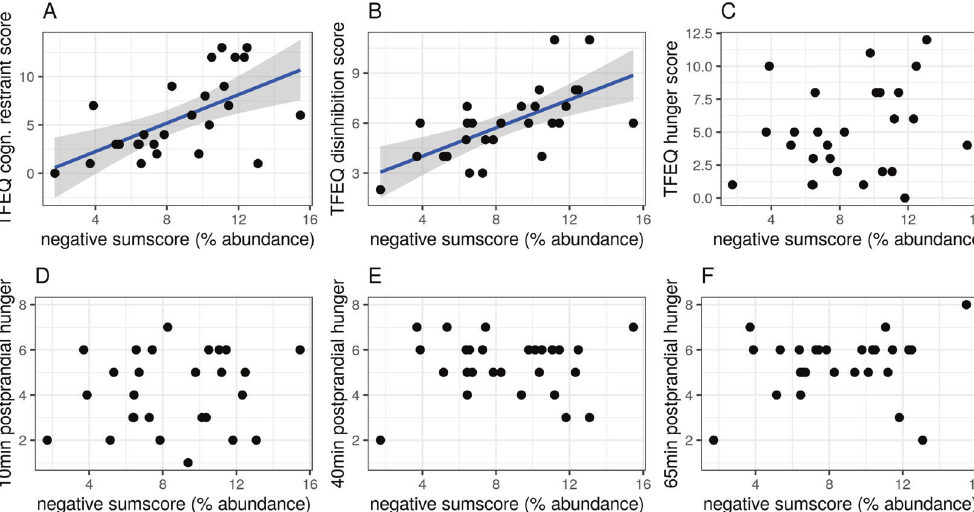
Fig. 5 Sumscore of inversely health-related genera is positively associated with eating traits (TFEQ). Pearson ’ s correlations shown for microbial genera abundance sumscore for inversely health-related genera with respect to eating behavior outcomes from TFEQ and hunger ratings shown for A ) cognitive restraint (r = 0.59, p-uncorr = 0.001) B ) disinhibition (r = 0.65, p-uncorr < 0.001) C ) hunger score D ) 10 min- postprandial hunger E ) 40 min-postprandial hunger and F ) 65 min-postprandial hunger. Data from sample 1, all